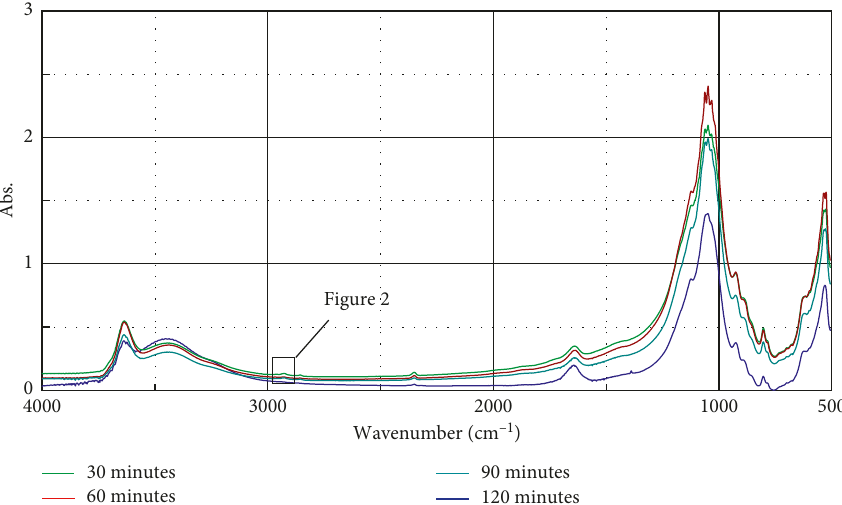
Figure 1: FT-IR spectra of nonmineralized mixture 80% (M80) mineralized at 500 ° C for different durations.